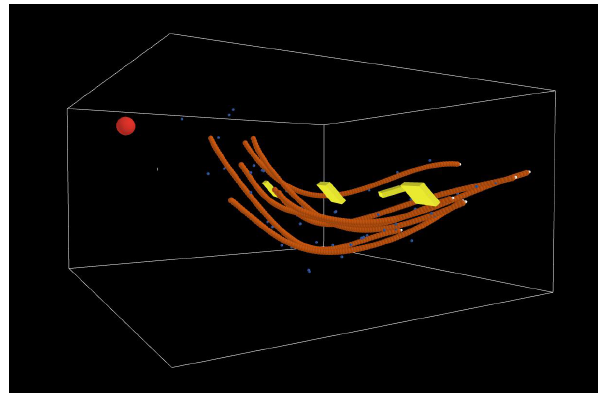
Figure 2. Structural form traces (orange point streams) estimated from dip data (yellow cuboids) using spatial agents. The red sphere is an interrogator agent. Blue dots are simulated Bézier control points with added random noise. See Appendix A for